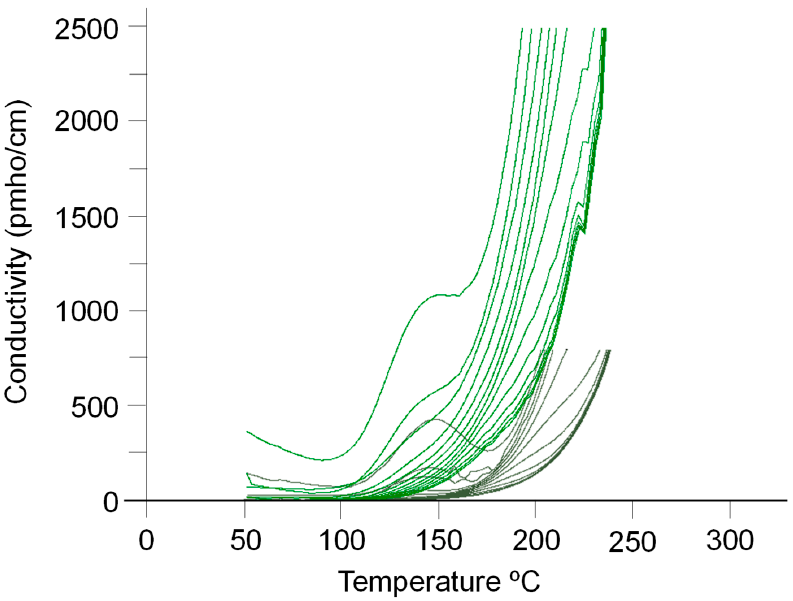
Figure 10. Conductivity σ as a function of the temperature at di ff erent applied frequencies for the system DGEBA/mXDA without (grey color) and with AuNPs (8.5%) (green color). system DGEBA/mXDA without (grey color) and with AuNPs (8.5%) (green